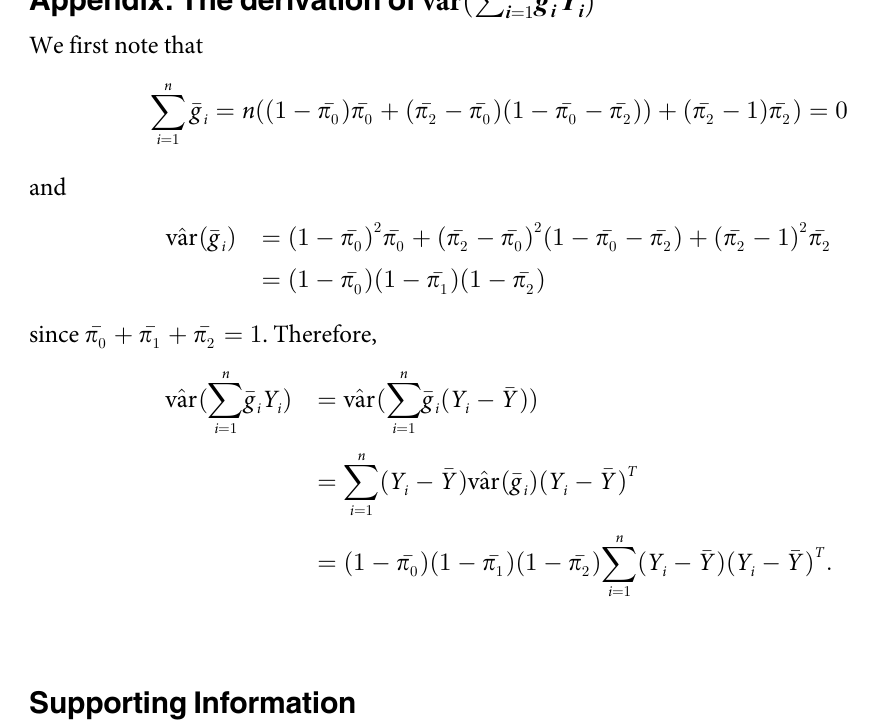
S1 Fig. The power of the multiple phenotypes association tests at the significance level 5 × 10 − 4 under different simulation settings. Different types of curve represent different methods. The simulation settings are the same as the simulation studies for bivariate pheno- types in Section 1.5. To alleviate the computational burden, the sample size was set to be 500, and the significance level was set to be